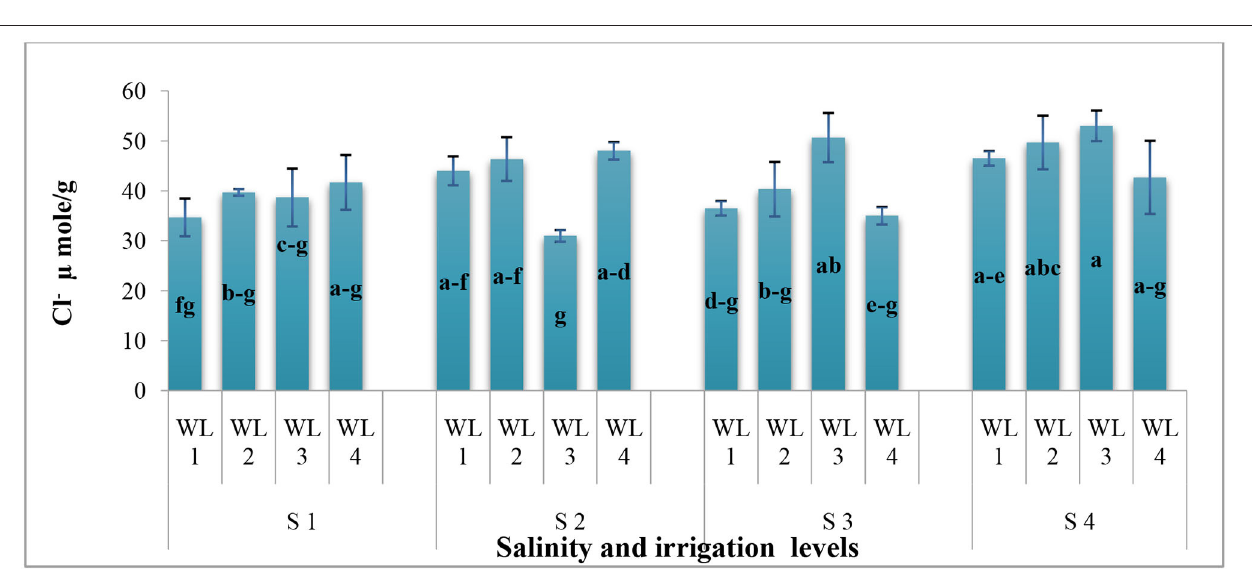
Figure 4 | Interactive effect of salinity and drought stress on the Chloride uptake ( µ mol g − 1 ) of S. imbricata . Value bars with different letters are significantly different from each other at α = 0.05, while error bar represents the standard error of mean ( n = 3). WL stands for water level (WL1 = 100% field capacity, WL2 = 80% field capacity, WL3 = 60% field capacity, and WL4 = 40% field capacity), while S represents salinity (S1 = 5 dS m − 1 , S2 = 10 dS m − 1 , S3 = 15 dS m − 1 , and S4 = 20 dS m − 1